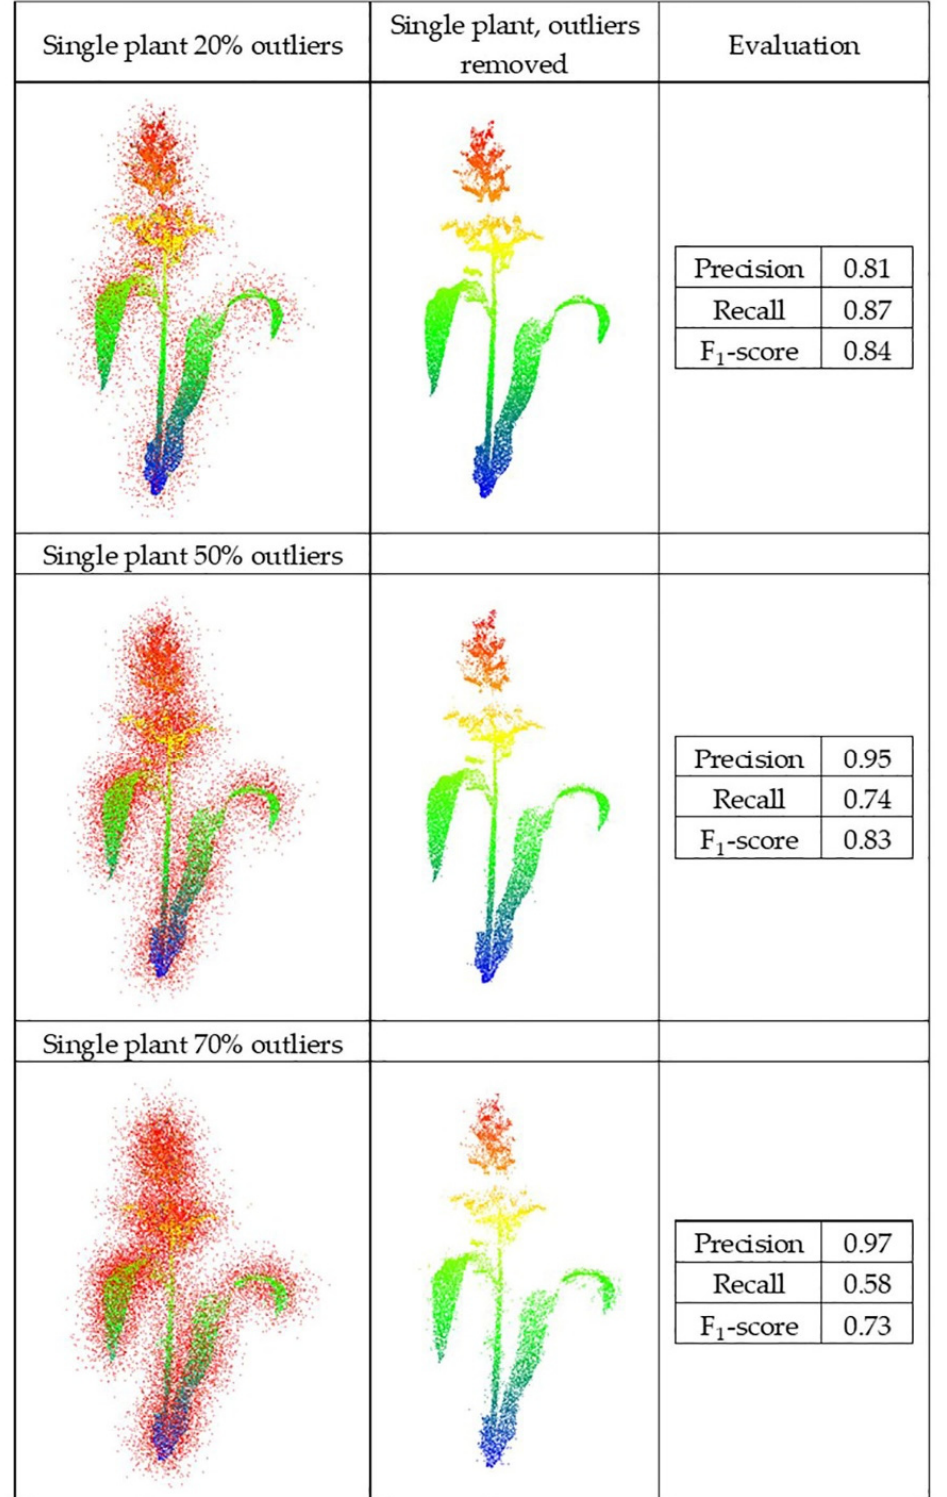
Figure 15. Outlier removal on individual plant LiDAR.